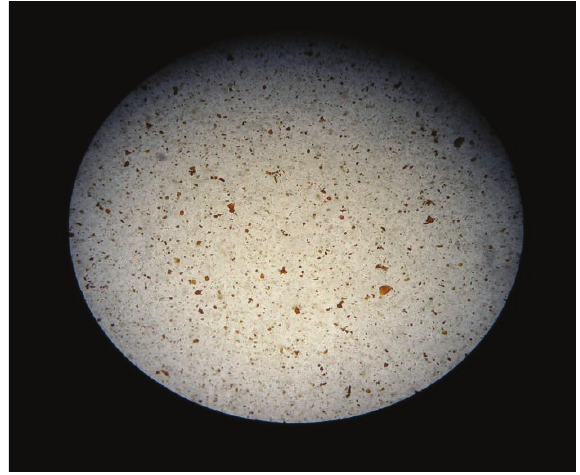
Figure5:Opticalmicroscopeimageofimmobilizednanozirconium tungestovanadate onto alginate